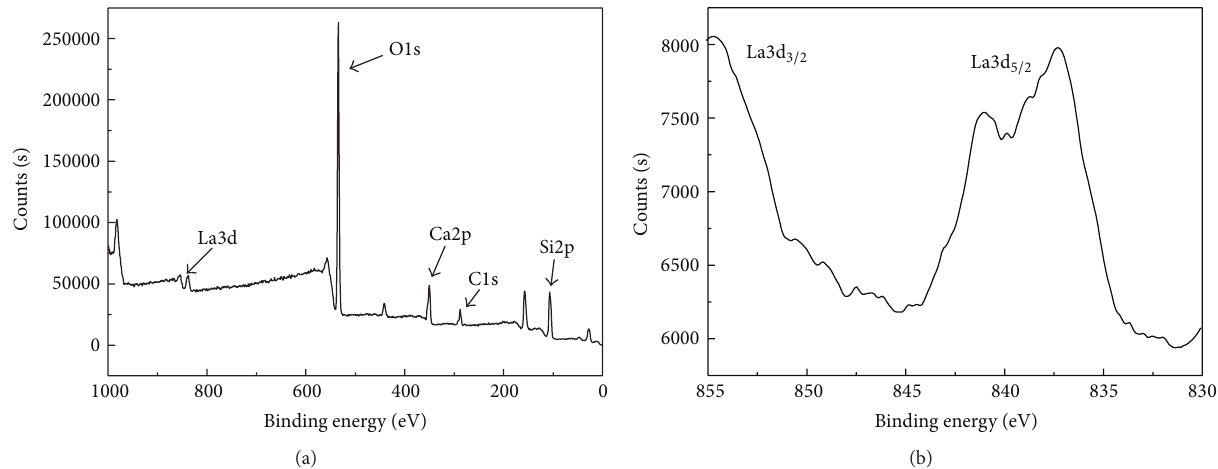
Figure 4: (a) The main elements XPS spectrum of BG-La-2; (b) lanthanum XPS spectrum of BG-La-2.